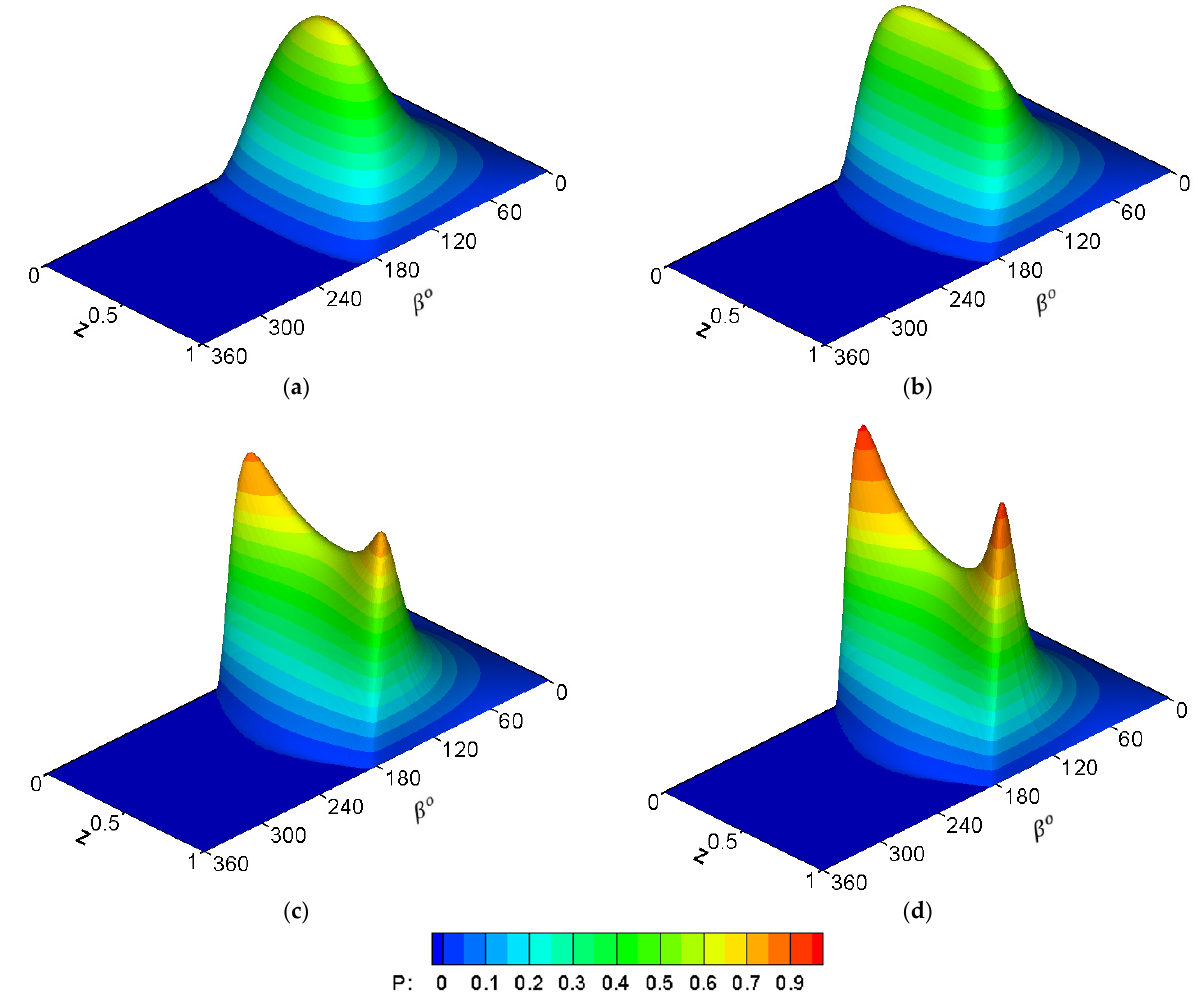
Figure 5. Effect of misalignment on dimensionless pressure distribution ( L / D = 1.25). ( a ): Aligned, ( b ): ∆ = 0.4, ( c ): ∆ = 0.55 and ( d ): ∆ = 0.58. ( β = θ − ∅ )